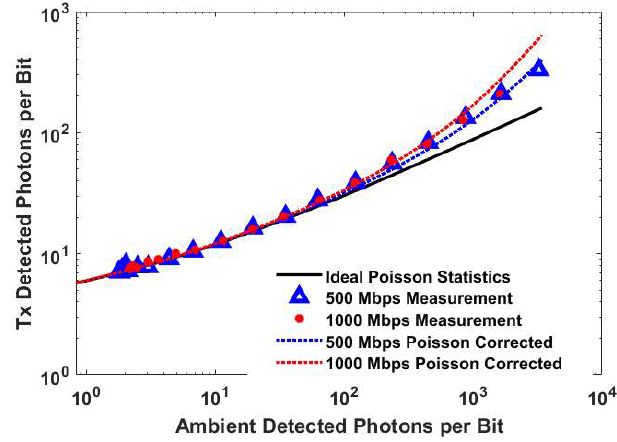
Figure 11. Experimental results for 500 Mbps and 1000 Mbps compared to the results expected from Poisson Theory and these results are combined with the correction, Equation (18). The x axis is the equivalent 405 nm irradiance that generates the same count rate and hence bias current as the incident ambient light.